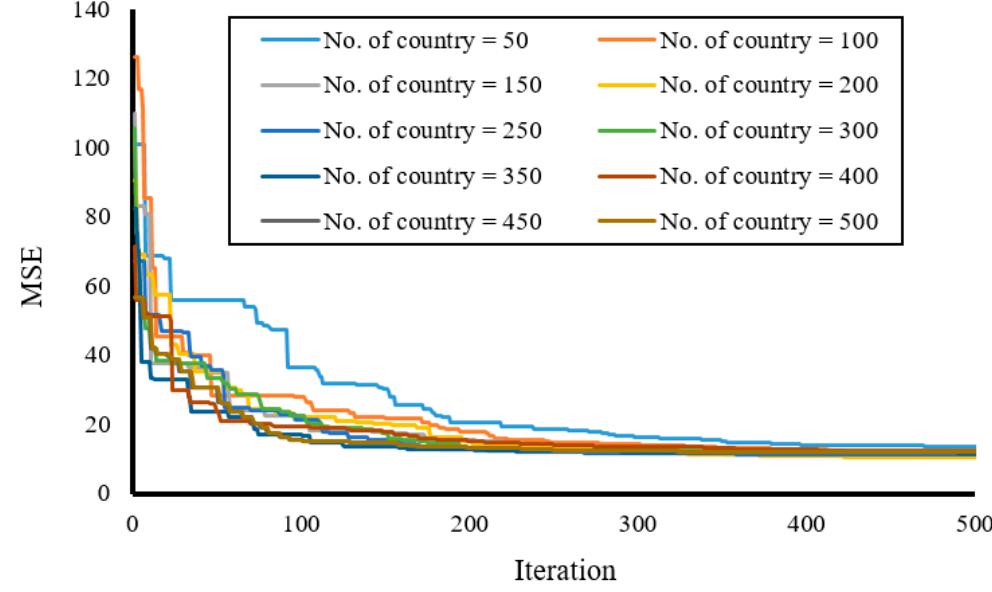
Figure 10. The sensitivity analysis for ICA-ANN, based on the number of countries.